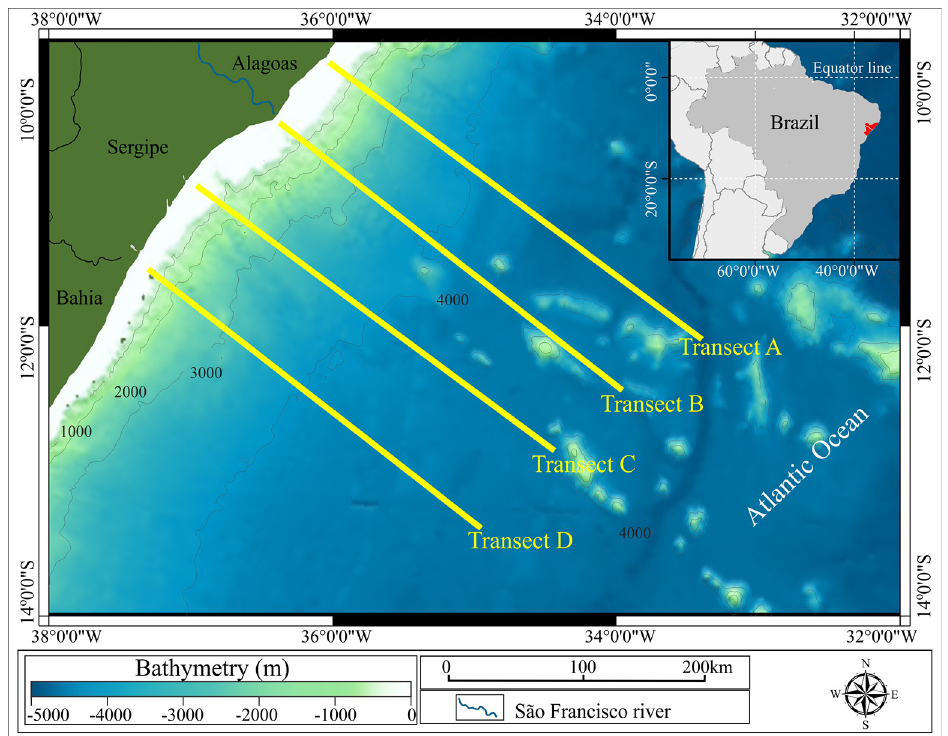
Fig 1. Reference map of the study site. Northeastern continental margin of Brazil, within the Sergipe–Alagoas sedimentary basin. Blue shades, local depth; yellow lines, sampling transects A, B, C, and D; blue line, S ã o Francisco river; dark green filled shape, Brazilian states that are adjacent to